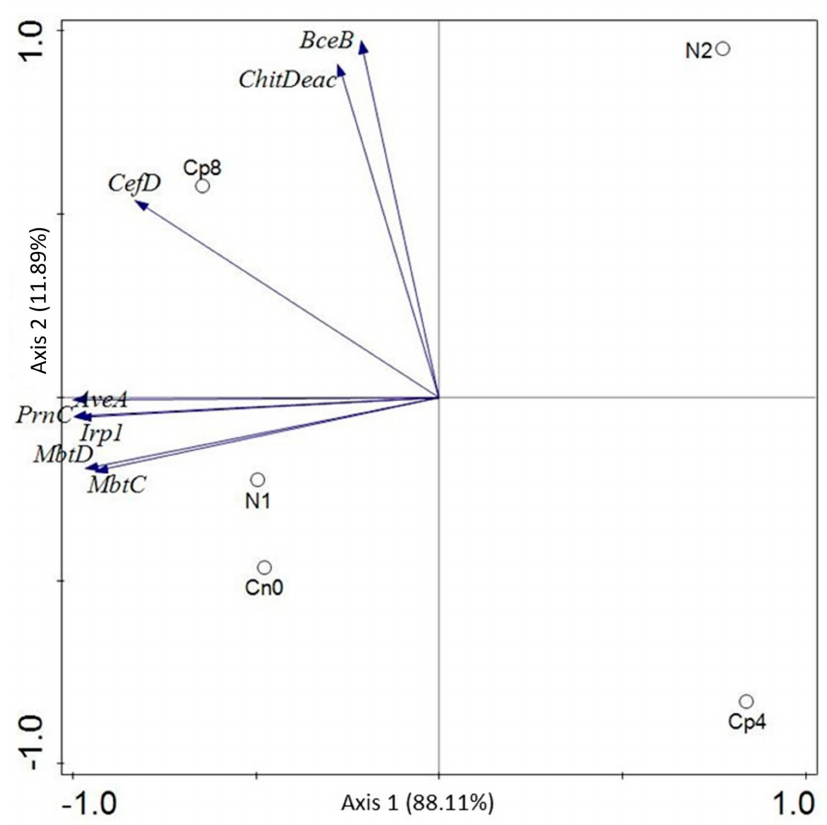
Figure 6. Principal component analysis for the identified disease suppressive genes in the maize rhizosphere treated with organic and inorganic fertilizers. Cn0 (control), Cp8 (8 tons/ha compost manure), Cp4 (4 tons/ha compost manure), N2 (120 kg/ha inorganic fertilizer), and N1 (60 kg/ha inorganic fertilizer).